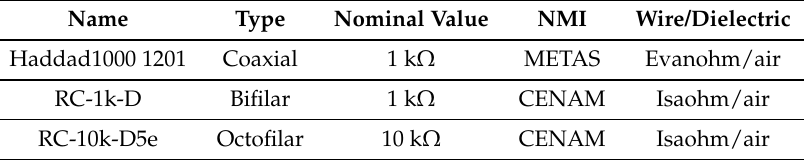
Table 3. Standards involved in the frequency evaluation of the CRs